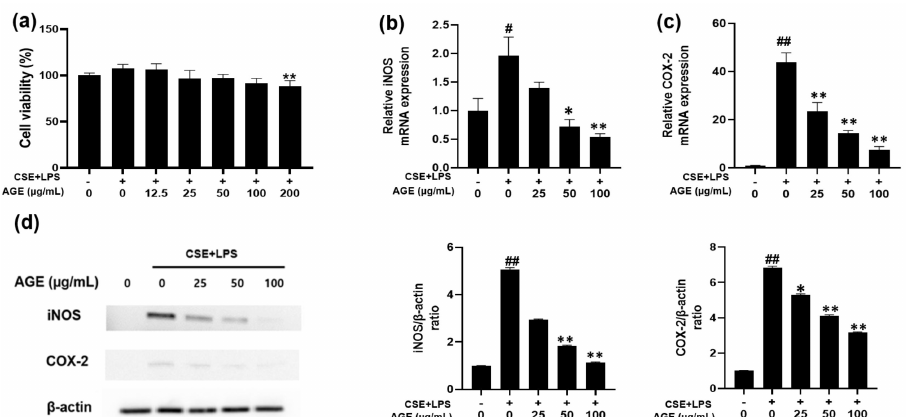
Figure 1. Effect of the Artemisia gmelinii ethanol extract (AGE) on cell viability and the expression levels of NOS2 and COX2 mRNA and protein in MH-S macrophages. For the cell viability assay ( a ), the MH-S macrophages were co-treated with 12.5, 25, 50, 100, 200 µ g/mL of AGE and CSE (1%)/LPS (10 ng/mL) for 24 h. Cell viability was estimated by the WST assay. To determine the expression of NOS2 COX2 mRNA ( b , c ) and protein ( d ), MH-S macrophages were co-treated with 25, 50, 100 µ g/mL of AGE and CSE (1%)/LPS (10 ng/mL) for 1 h ( NOS2 mRNA), 6 h ( COX2 mRNA), 12 h (iNOS and COX2 protein), respectively. The expression of mRNA and protein was measured by quantitative real-time polymerase chain reaction and Western blotting, respectively. Western blot data were quantitatively analyzed using FUSION Solo S software. Data are presented as means ± SD ( n = 3). The significant differences among the groups were analyzed using one-way analysis of variance by Bonferroni’s test (# p < 0.05 and ## p < 0.01 compared to the control group; * p < 0.05 and ** p < 0.01 compared to the CSE + LPS-stimulated